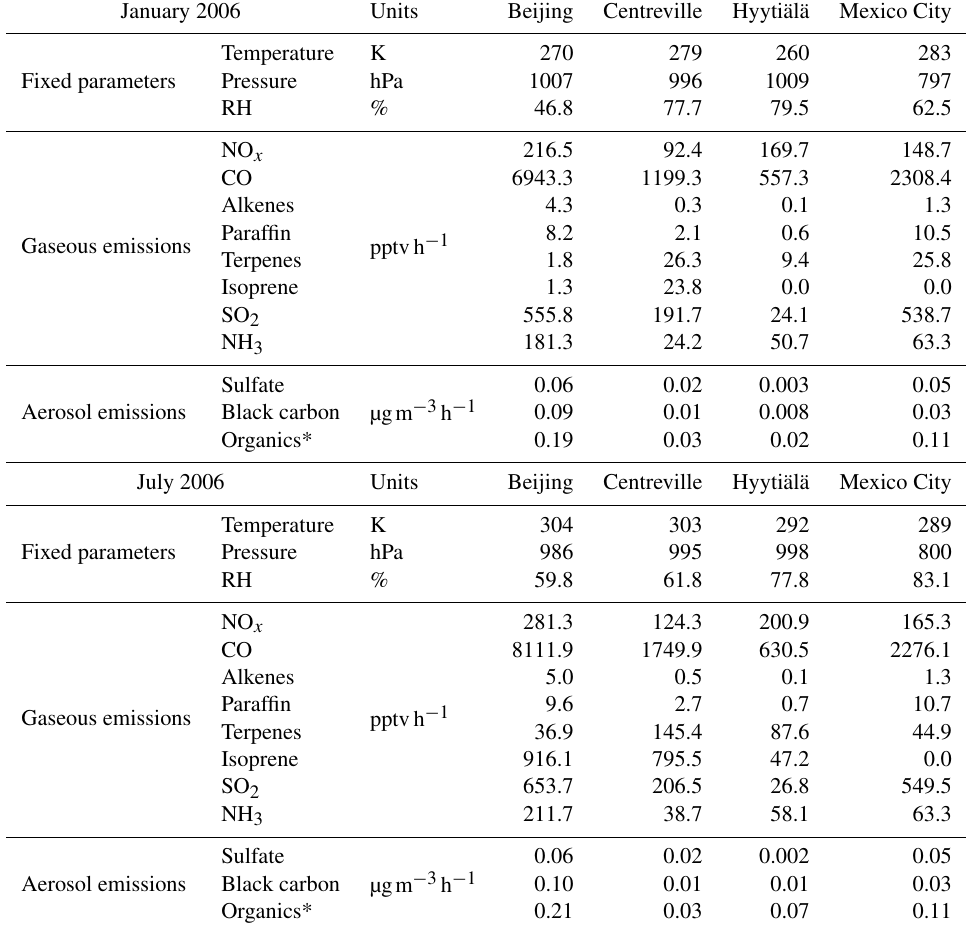
Table 3. Conditions of each location used in the simulations, taken from the GISS ModelE for January and July 2006.